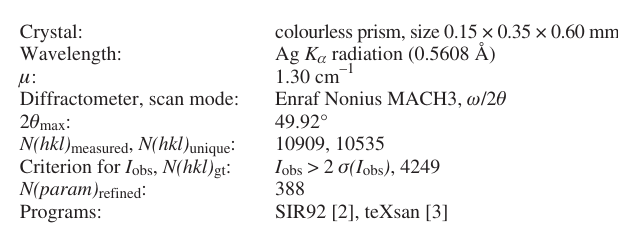
Table 1. Data collection and handling.